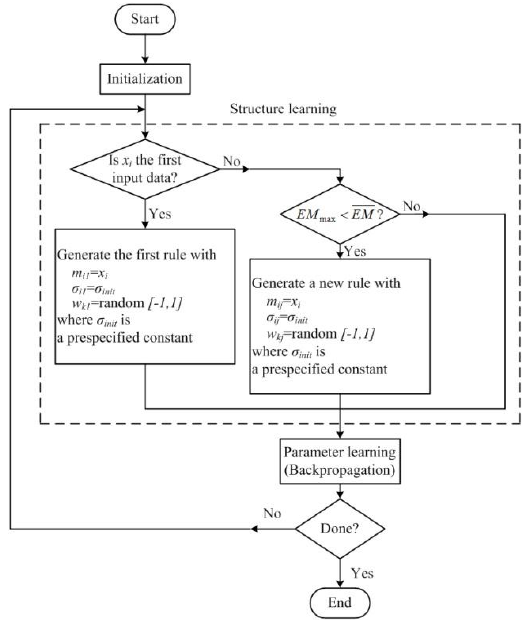
Figure 2. Flowchart of the proposed learning algorithm.